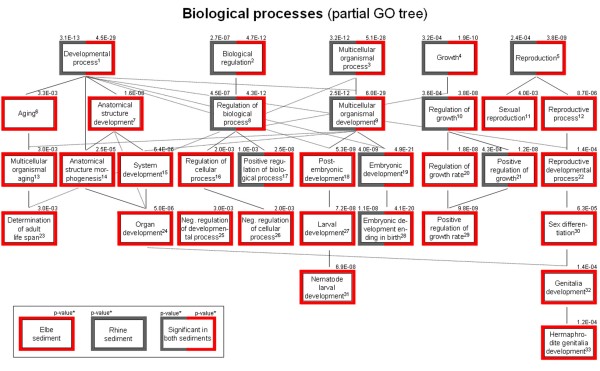
Biological processes – partial GO tree. Partial GO tree presenting relevant biological processes which were found to be overrepresented in C elegans exposed to Elbe and/or Rhine sediment.